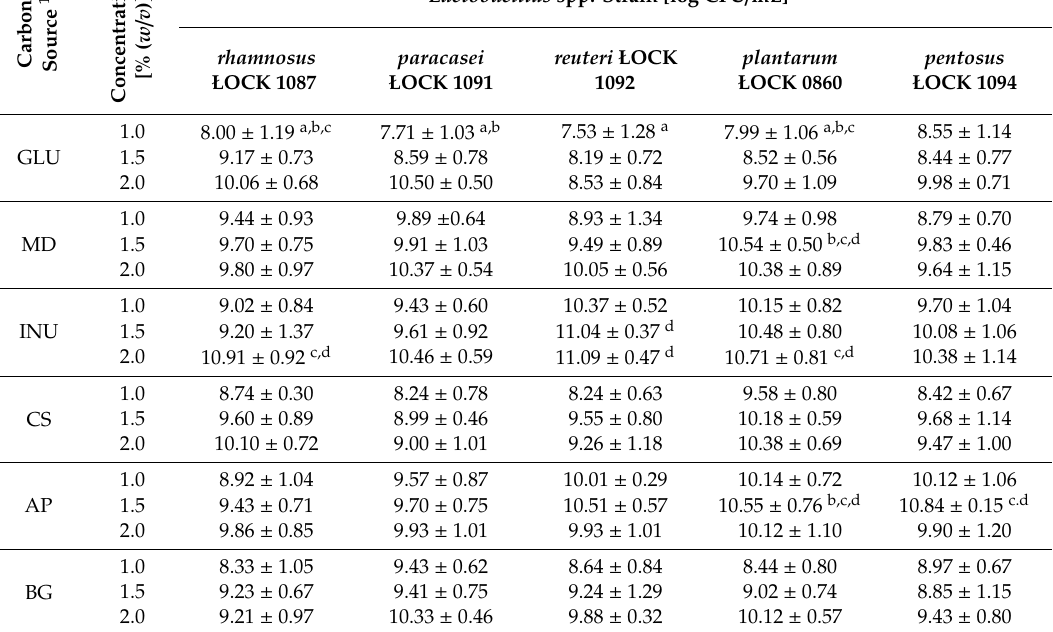
Table 2. The e ff ect of the carbon source on the growth of Lactobacillus spp.